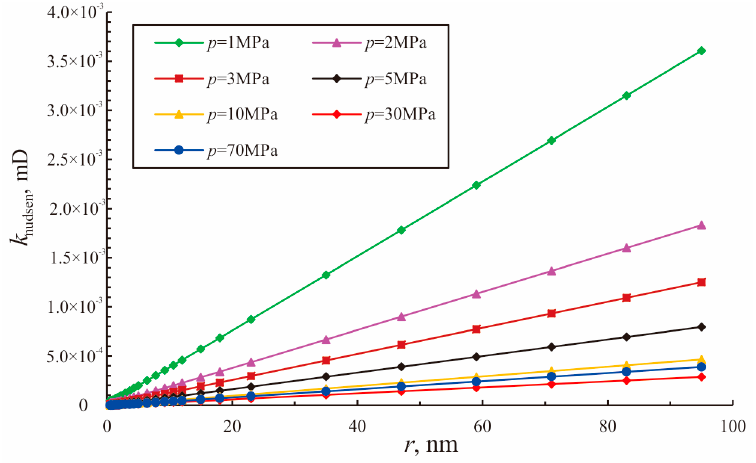
Figure 11. Equivalent permeability Knudsen diffusion in different conditions.